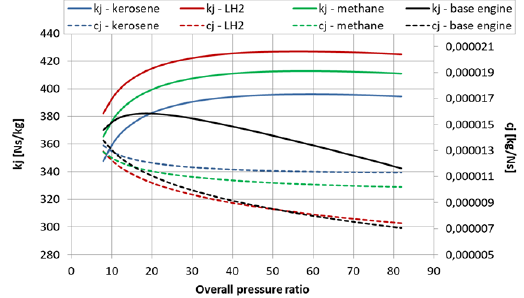
Fig. 3. Specific thrust and specific fuel consumption in function of engine pressure